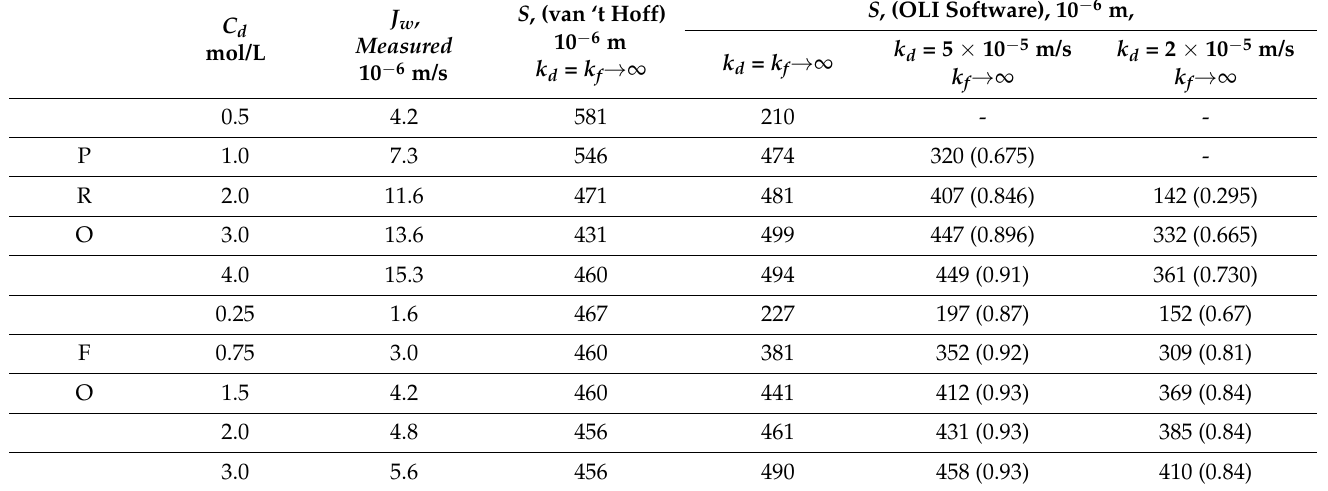
Table 6. Application of measured data of Tang et al. [37] to recalculate the effect of the measured water flux on the prediction of structural parameter, using OLI software instead of the van ’t Hoff linear approach, and to illustrate the effect of the external transfer coefficient on the predicted values of S . The first two columns (water flux, predicted structural parameter) are data published in [37], and the other data are calculated by authors of this paper. A – S indicates that it is less than zero, i.e., the measured water flux is higher than expected for the tested conditions. ( A = 2.22 × 10 − 7 m/s · bar; B = 1.7 × 10 − 7 m/s; D = 1.5 × 10 − 9 m 2 /s; C f = 0.01 M; ∆ P =